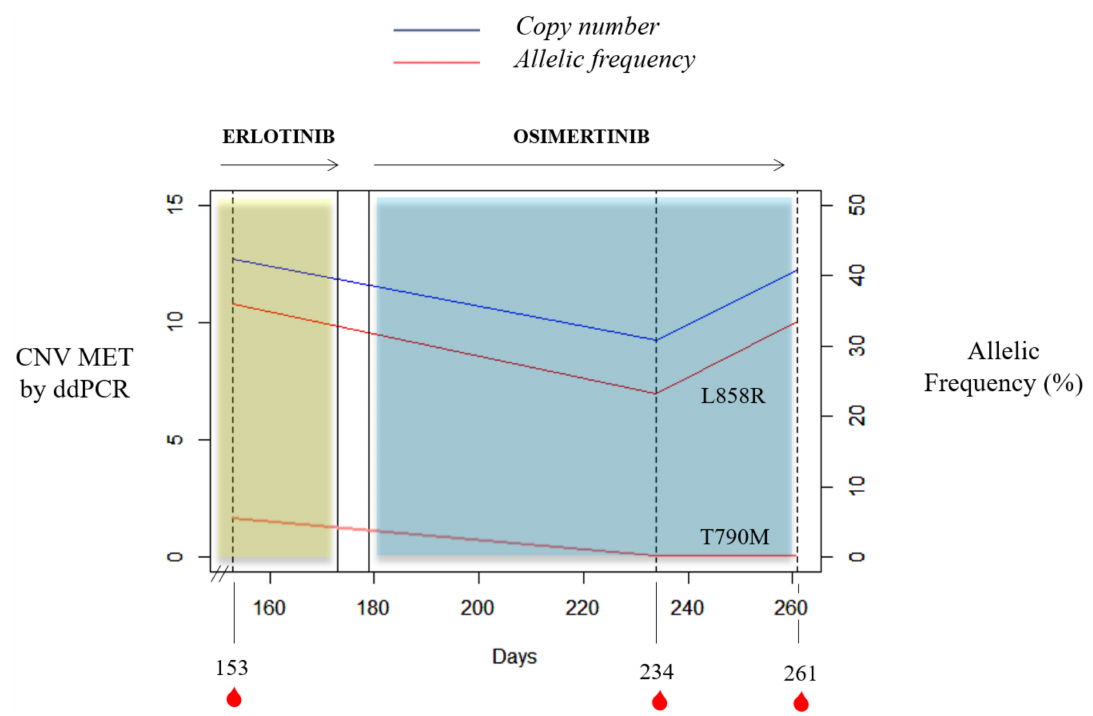
Figure 8. Timeline for the clinical course of patient id60. The blue and yellow bars represent the treatments time frame, and the red drops indicate blood collection time points. Percent mutant allelic frequency (L858R and T790M) and MET CN for patient id60 are